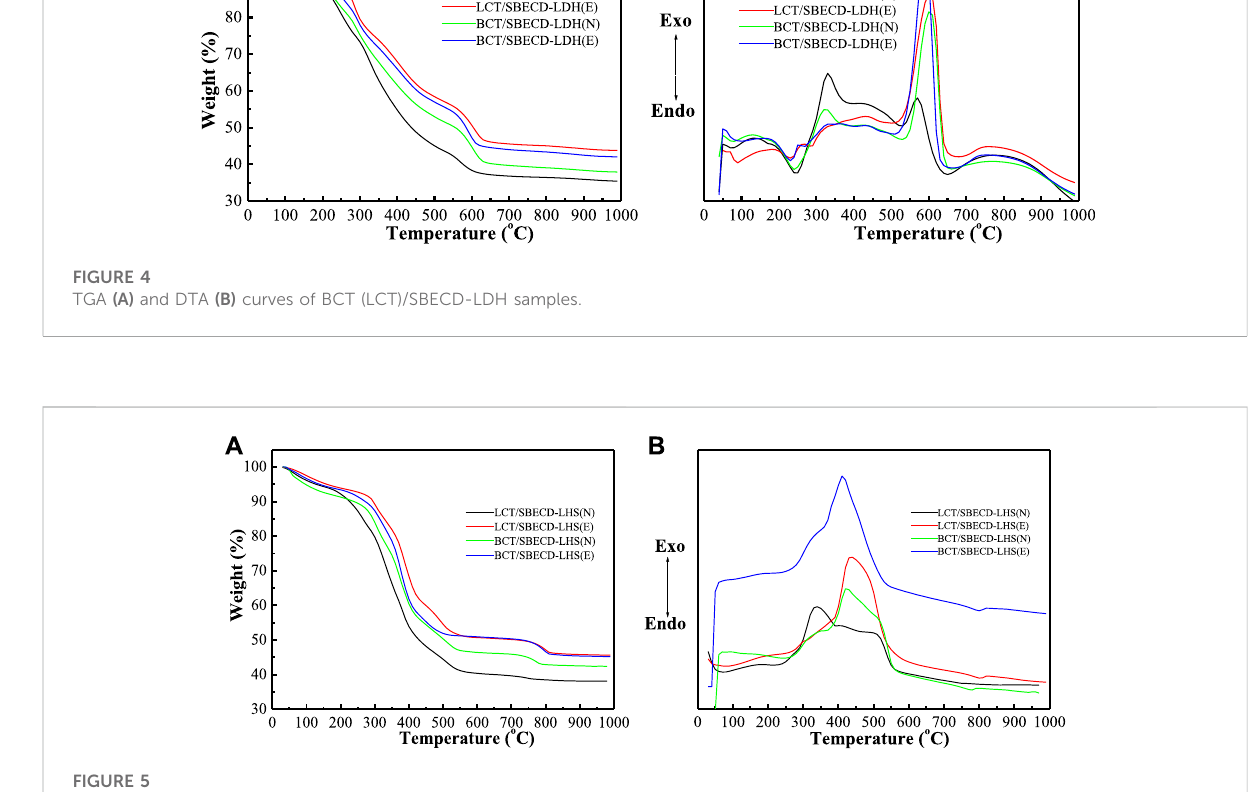
FIGURE 5 TGA (A) and DTA (B) curves of BCT (LCT)/SBECD-LHS